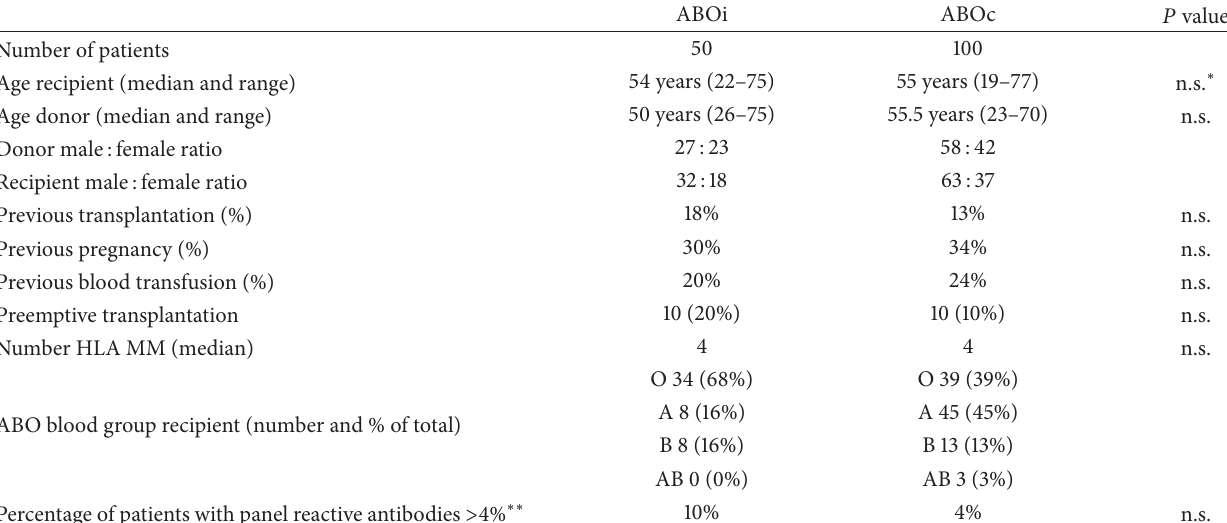
Table 1: Clinical and demographic characteristics of patients receiving a blood type ABO-incompatible (ABOi) kidney transplant and matched ABO-compatible (ABOc)